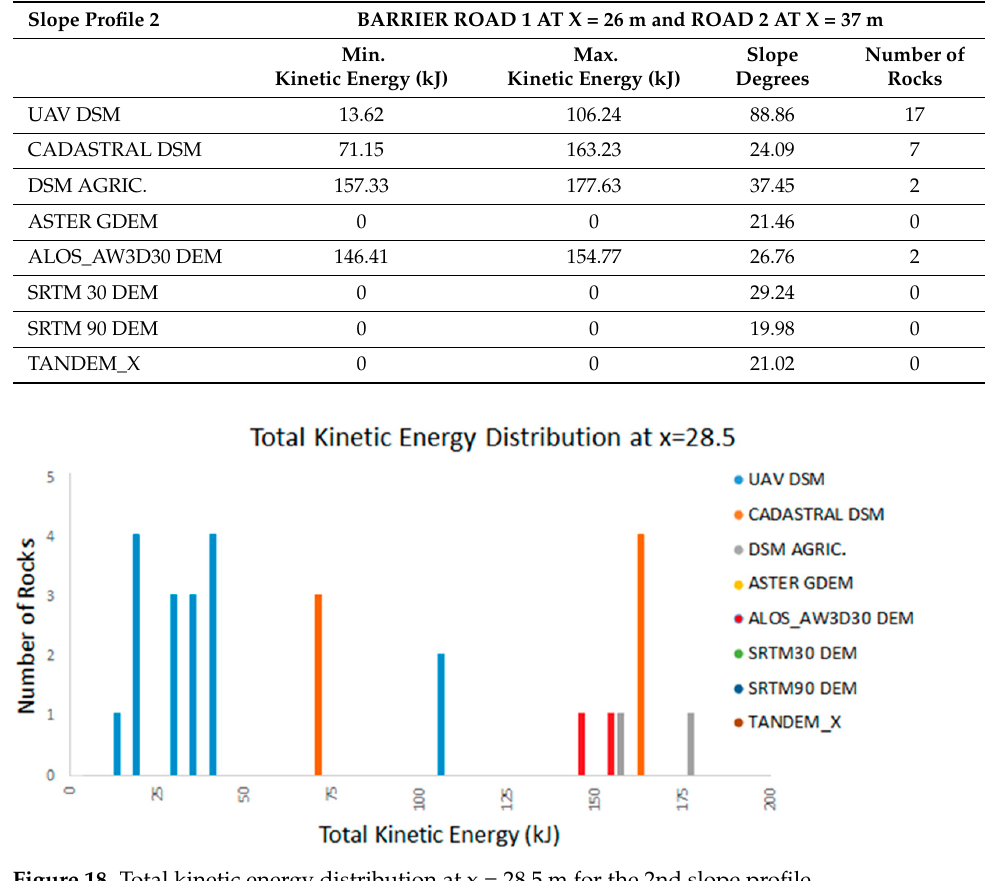
Figure 18. Total kinetic energy distribution at x = 28.5 m for the 2nd slope profile. The total kinetic energy was computed in the middle of the slope profile at the location x = 28.5 m. This position is after the first barrier/road (x = 26 m) and before the second (x = 37 m). According to the diagram “horizontal location of rock end points”, in ASTER GDEM, SRTM30 DEM, SRTM90 DEM and TanDEM_X slope profiles, the rocks stopped at the first barrier/road (x = 26 m). Consequently, at the location x = 28.5 m, the number of rocks was zero and, thus, there was no kinetic energy. In contrast, in the UAV DSM,